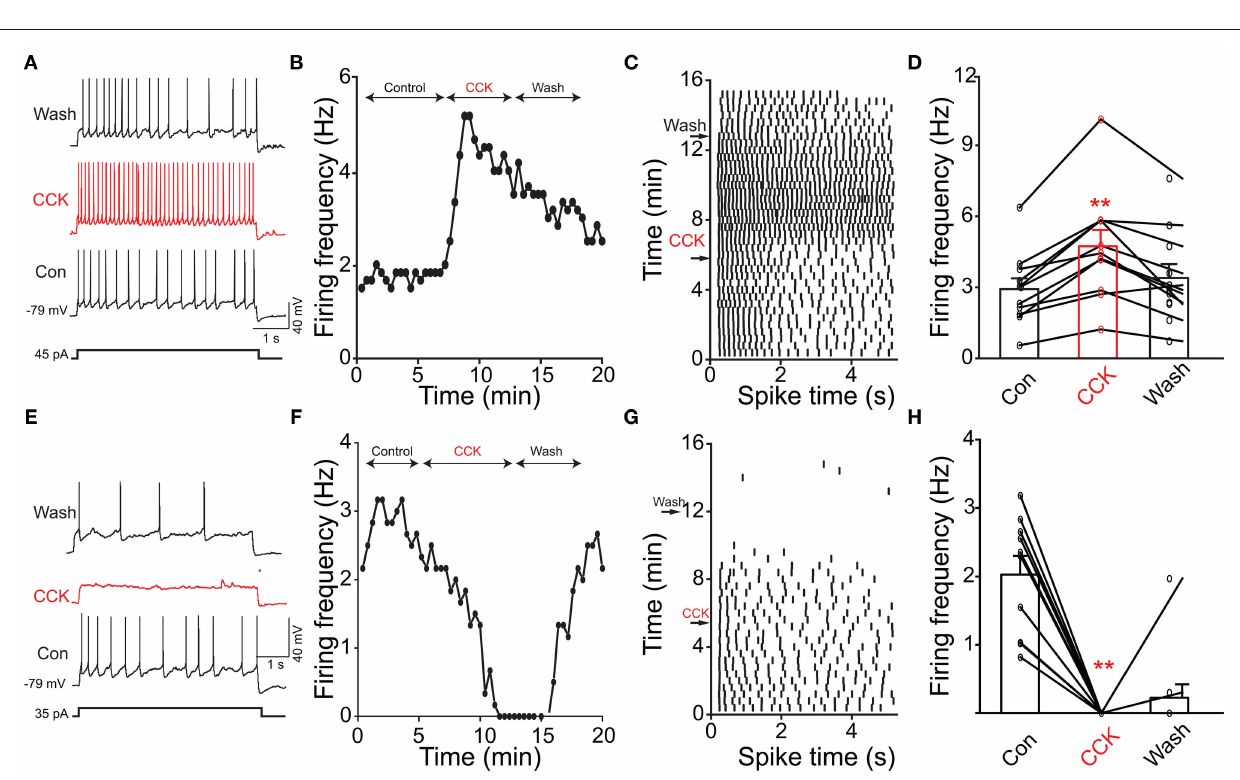
a two-tailed, paired t- test or a one-way repeated measures (RM) analysis of variance (ANOVA) at the 95% confidence level ( α = 0.05). All sampled populations were analyzed using Prism 6 (GraphPad Software Inc., CA, USA). All reported values are mean (standard deviation -SD) unless otherwise